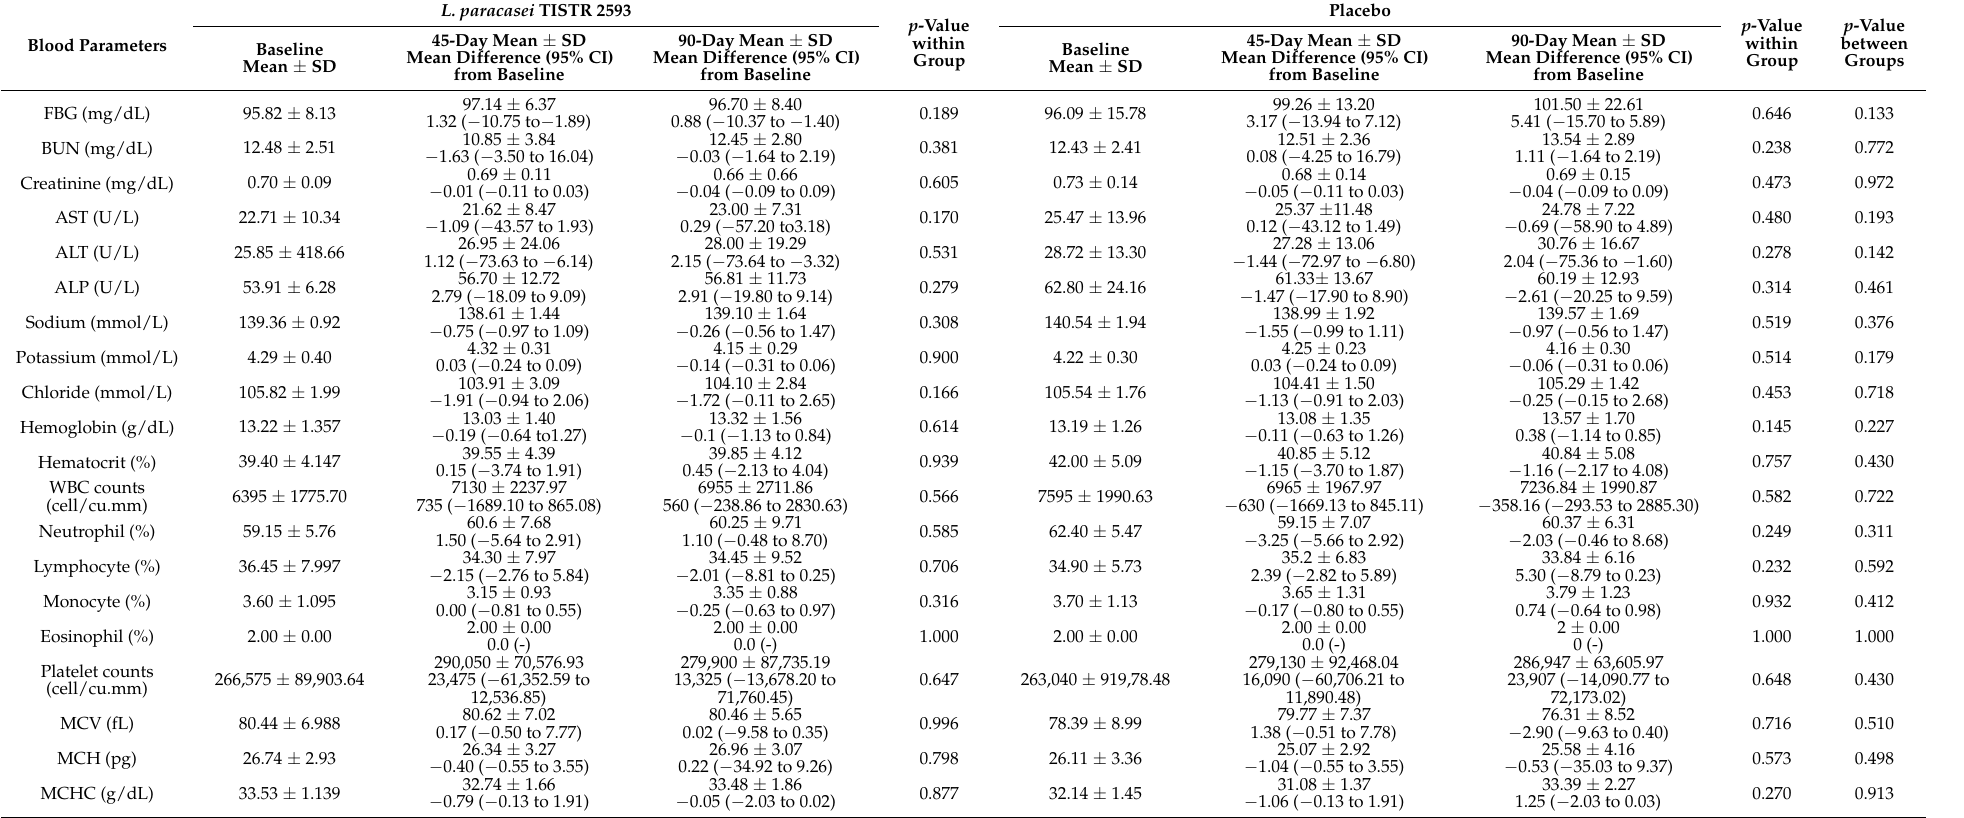
Table 2. Effect of L. paracasei TISTR 2593 supplementation on blood safety